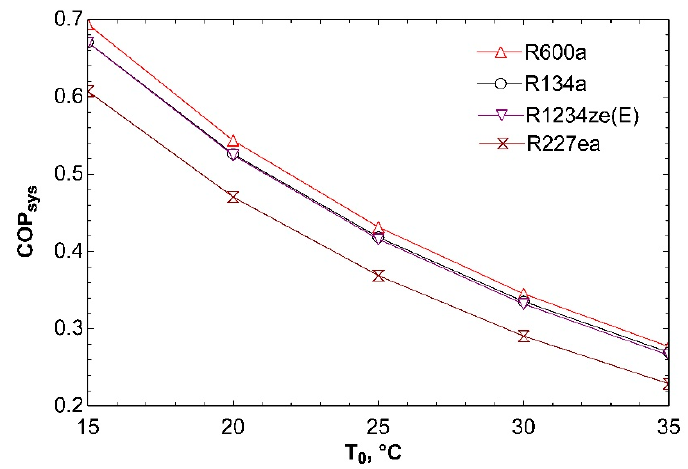
Figure 15. Influence of T 0 on COP sys in combined ORC-dual evaporator VCR cycle.